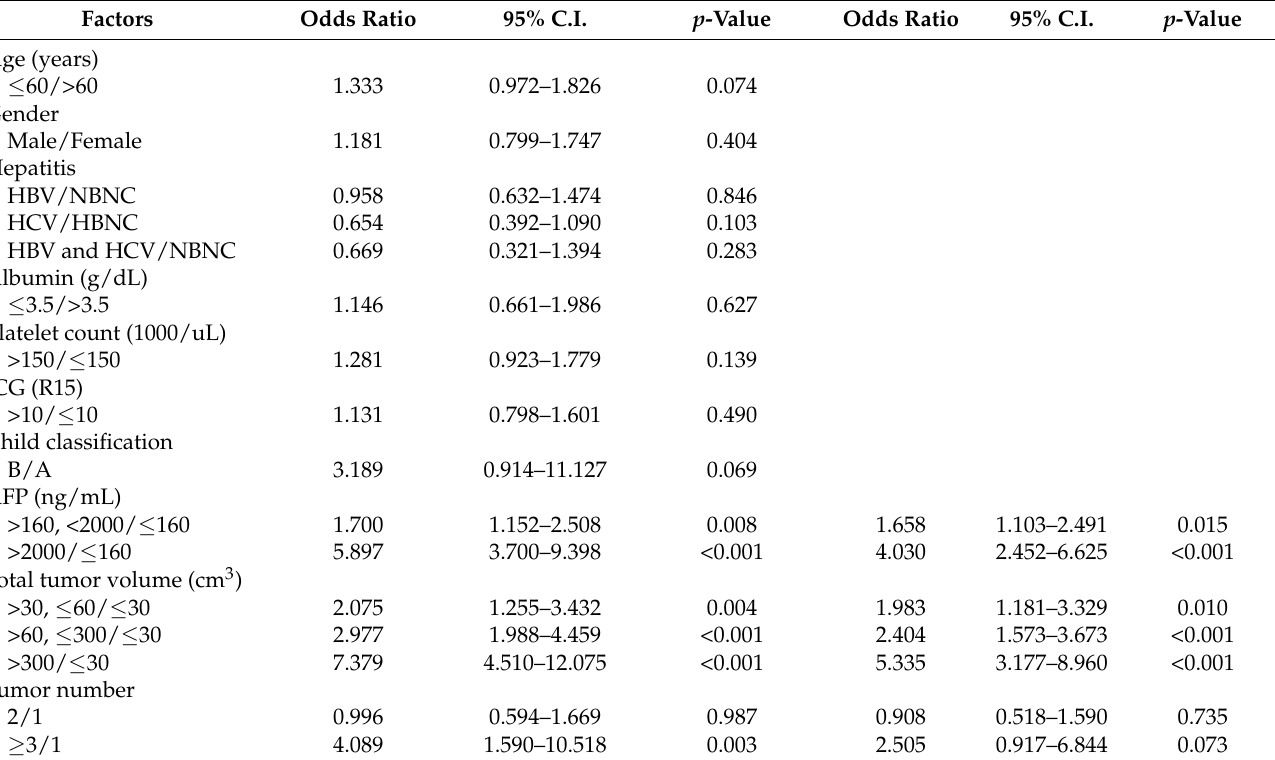
Table 2. Prognostic factors for microvascular invasion according to univariate and multivariate analysis using a training